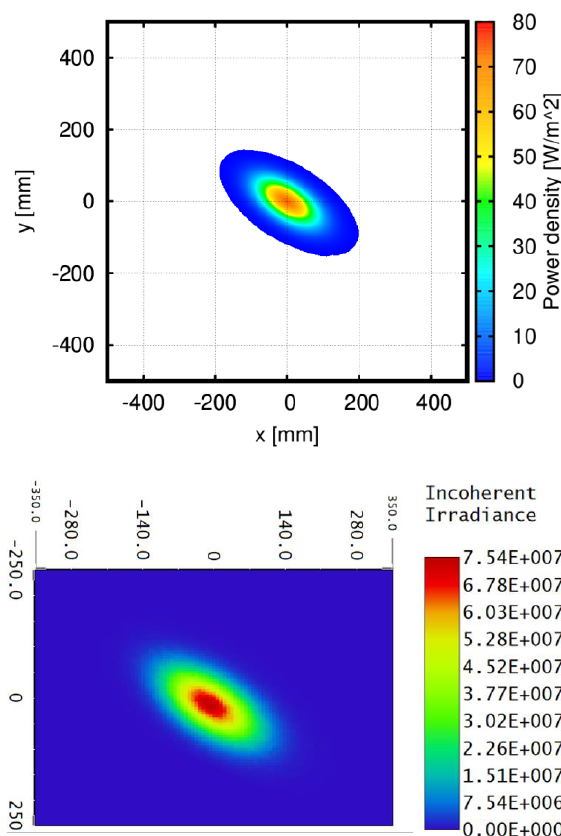
Fig. 14. Field of the beam U2 after the mirror UA calculated with PROFUSION (top) and Zemax